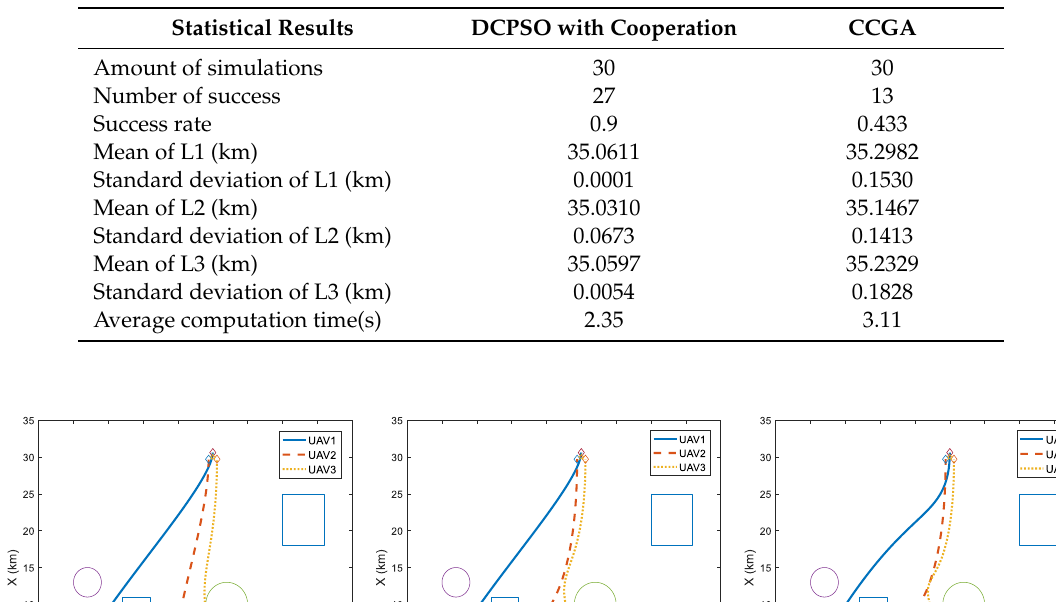
Table 4. Statistical results of 30 simulations.